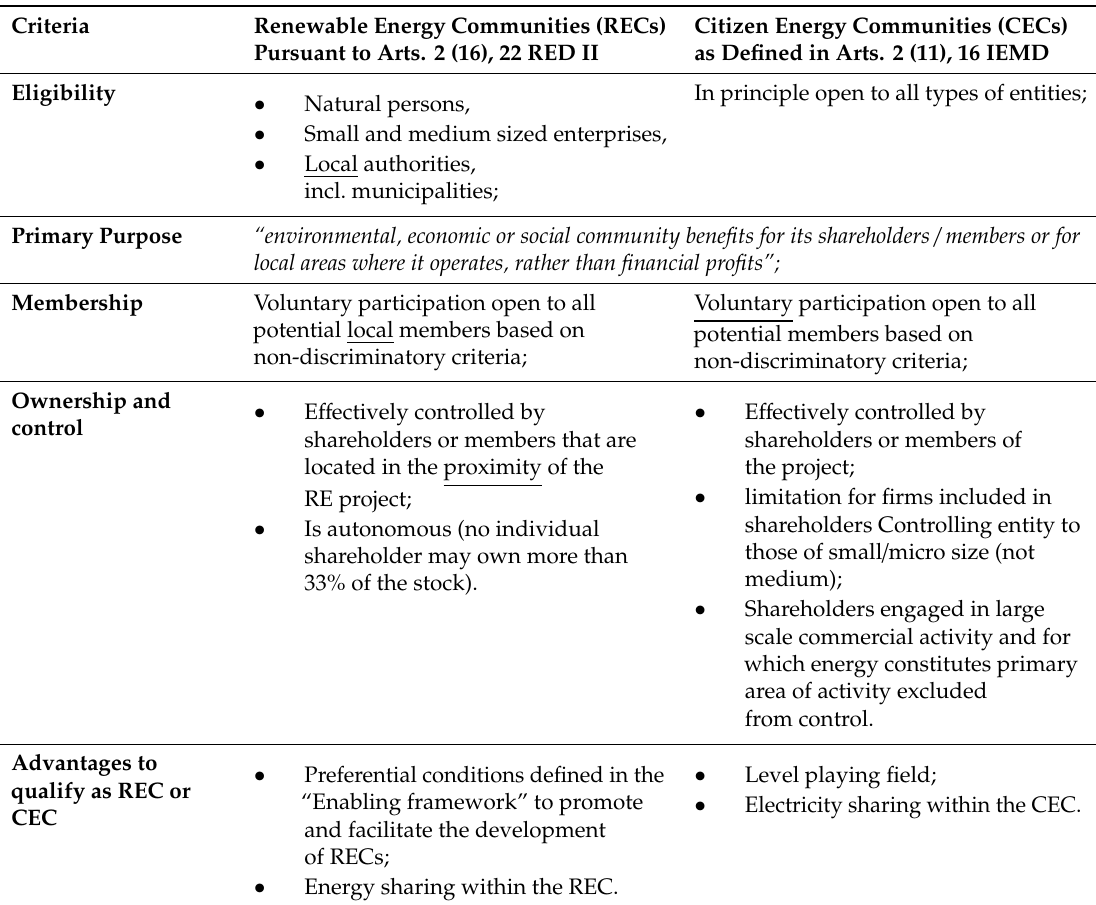
Table 1. The new governance model for energy communities under Renewable Energy Directive (RED) II and Internal Electricity Market Directive (IEMD). Source: Modified after Lowitzsch, Hoicka, van Tulder